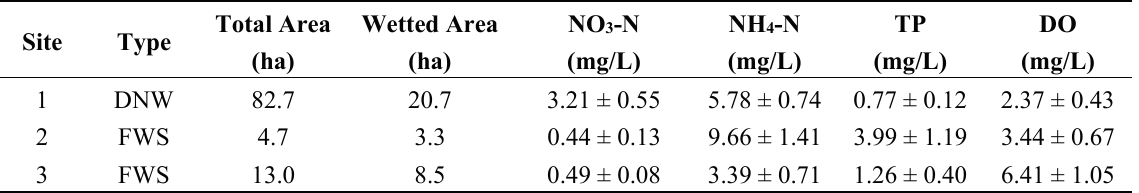
1. Map showing the locations of the three study urbanized wetlands. Site 1 = Huajiang Wetland; Site 2 = Hsin-Hai Constructed Wetland; Site 3 = Daniaopi Constructed Wetland. 1. Environmental characteristics of the three study urbanized wetlands including wetland type, total area, wetted area, and mean ± SE of nutrient and dissolved oxygen